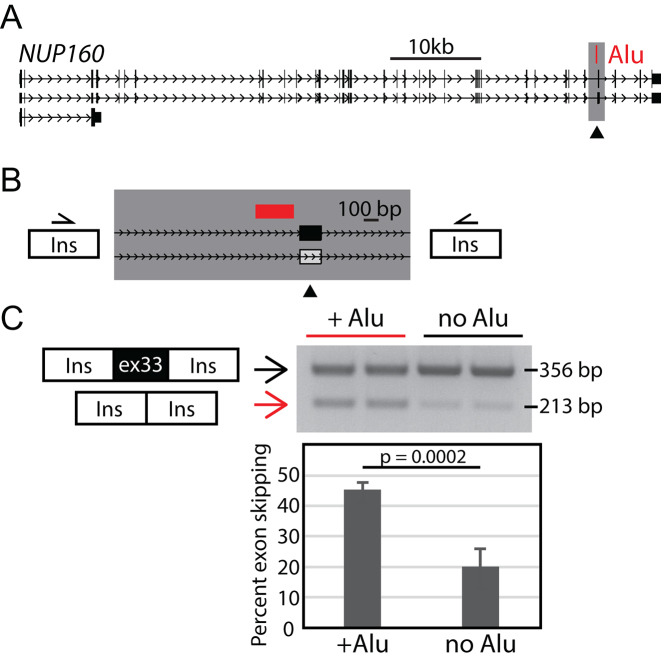
Polymorphic Alu results in increased exon skipping at NUP160. (A) NUP160 locus. A polymorphic AluYh3a3 (red) is sense with respect to NUP160 transcription and maps 41 bp upstream of alternatively used exon 33 (arrowhead). The region included in the splicing reporter is highlighted in gray. (B) Spicing reporter assay of Alu insertion effects at NUP160 locus. Minigene-splicing reporters contain the genomic segment (gray box, also from A) with and without the Alu present (red). White box indicates exon is skipped in rare isoforms according to EST data. (C) A representative gel showing splicing assay amplicons from two independent clones for each construct assayed. Two bands of indicated sizes were quantified on an agarose gel after PCR with primers in the rat insulin (Ins) exons. The larger product incorporates NUP160 exon 33. Data were combined with a second replicate and graphed. Error bars are the standard deviation of the four values for each construct. Unpaired t-test results are shown.